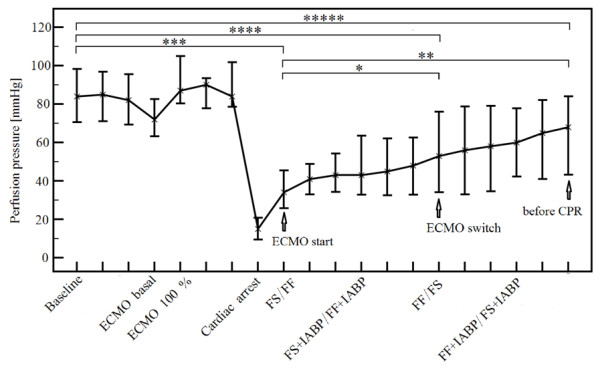
Coronary perfusion pressure during the whole protocol. Pooled from all eleven animals as medians with 25- and 75-percentiles represented by vertical bars. See the gradual rise of perfusion pressure after the ECMO start. Respective statistical comparisons delineated by horizontal bars, statistically significant differences in bold:*****P = 0.076;****P = 0.007; *** P < 0.001; **P = 0.003; *P = 0.037.